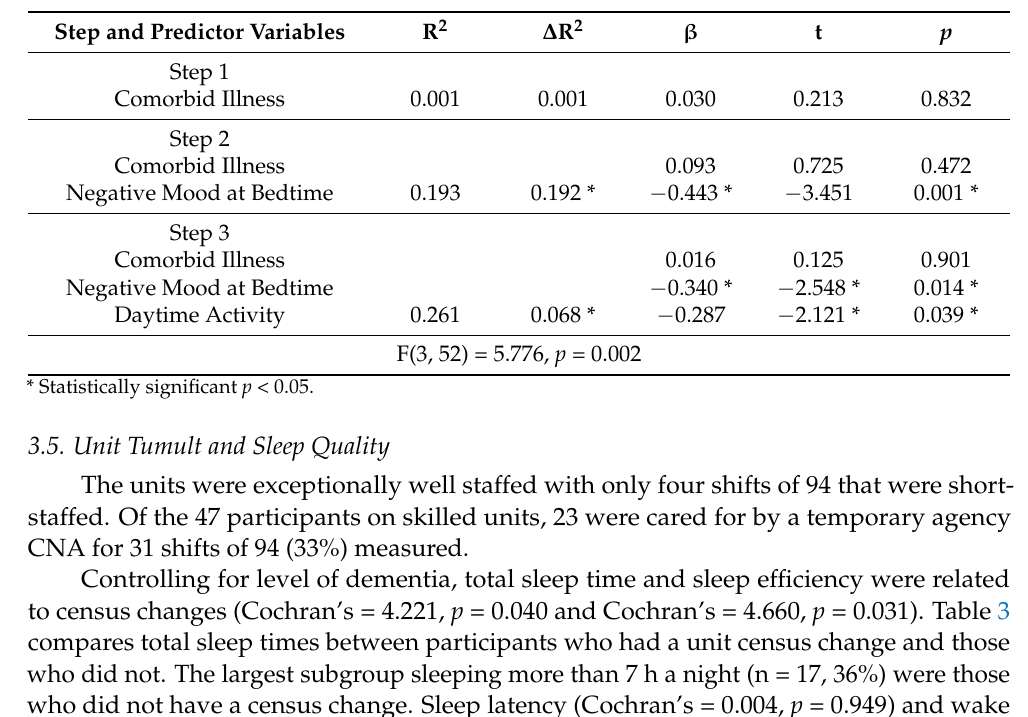
Table 2. Summary of Hierarchical Regression Analysis with Total Sleep Minutes as Criterion (N =